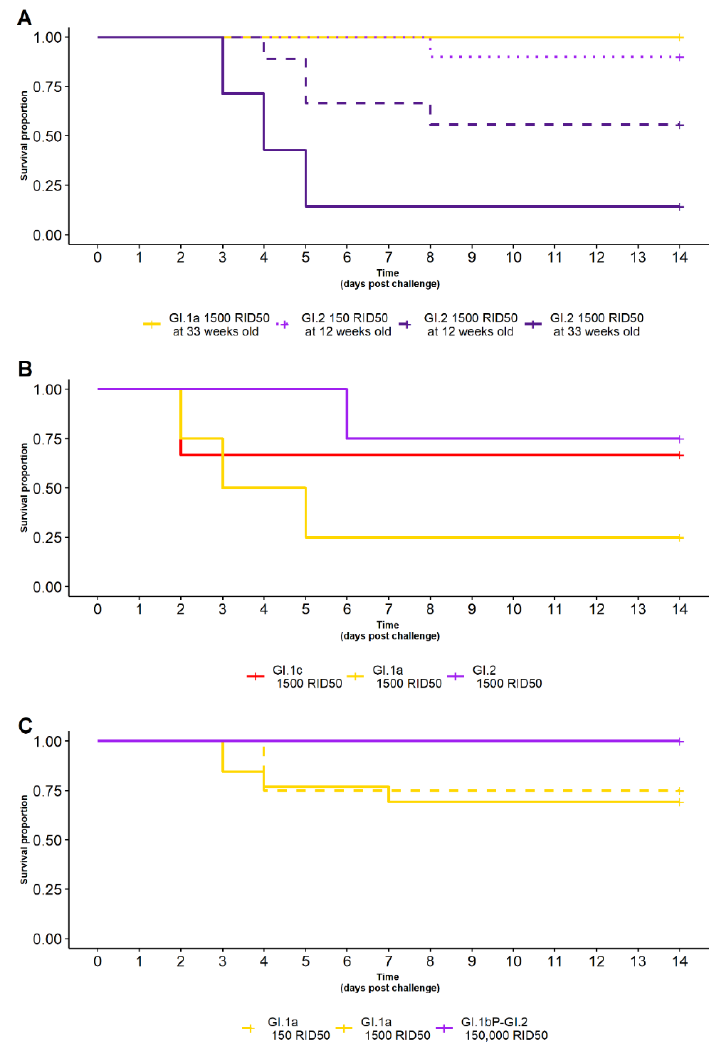
Figure 5. ( A ) Survival curve of rabbits with naturally acquired GI.1 immunity challenged with GI.1a (yellow), or with various doses of GI.2 (150 RID 50 —dotted-purple, 1500 RID 50 —purple) at different ages (12 weeks — purple dashed line, 33 weeks — purple solid line). All rabbits survived GI.1a challenge. A dose-dependent and age-related difference in survival was observed against GI.2 challenge, with rabbits given a higher dose or challenged at an older age less likely to survive. ( B ) Survival curve of rabbits with naturally acquired GI.2 immunity after GI.1c (red), GI.1a (yellow) or GI.2 (purple) challenge. Fewer rabbits survived a GI.1a challenge compared to the other challenge viruses. ( C ) Survival curve of rabbits with RHDV (GI.4cP-GI.2) immunity after heterologous GI.2 (purple) or GI.1a challenge at various doses (150 RID 50 — yellow-dashed, 1500 RID 50 — yellow-solid). All rabbits survived GI.2 challenge, whereas fewer rabbits survived GI.1a challenge.